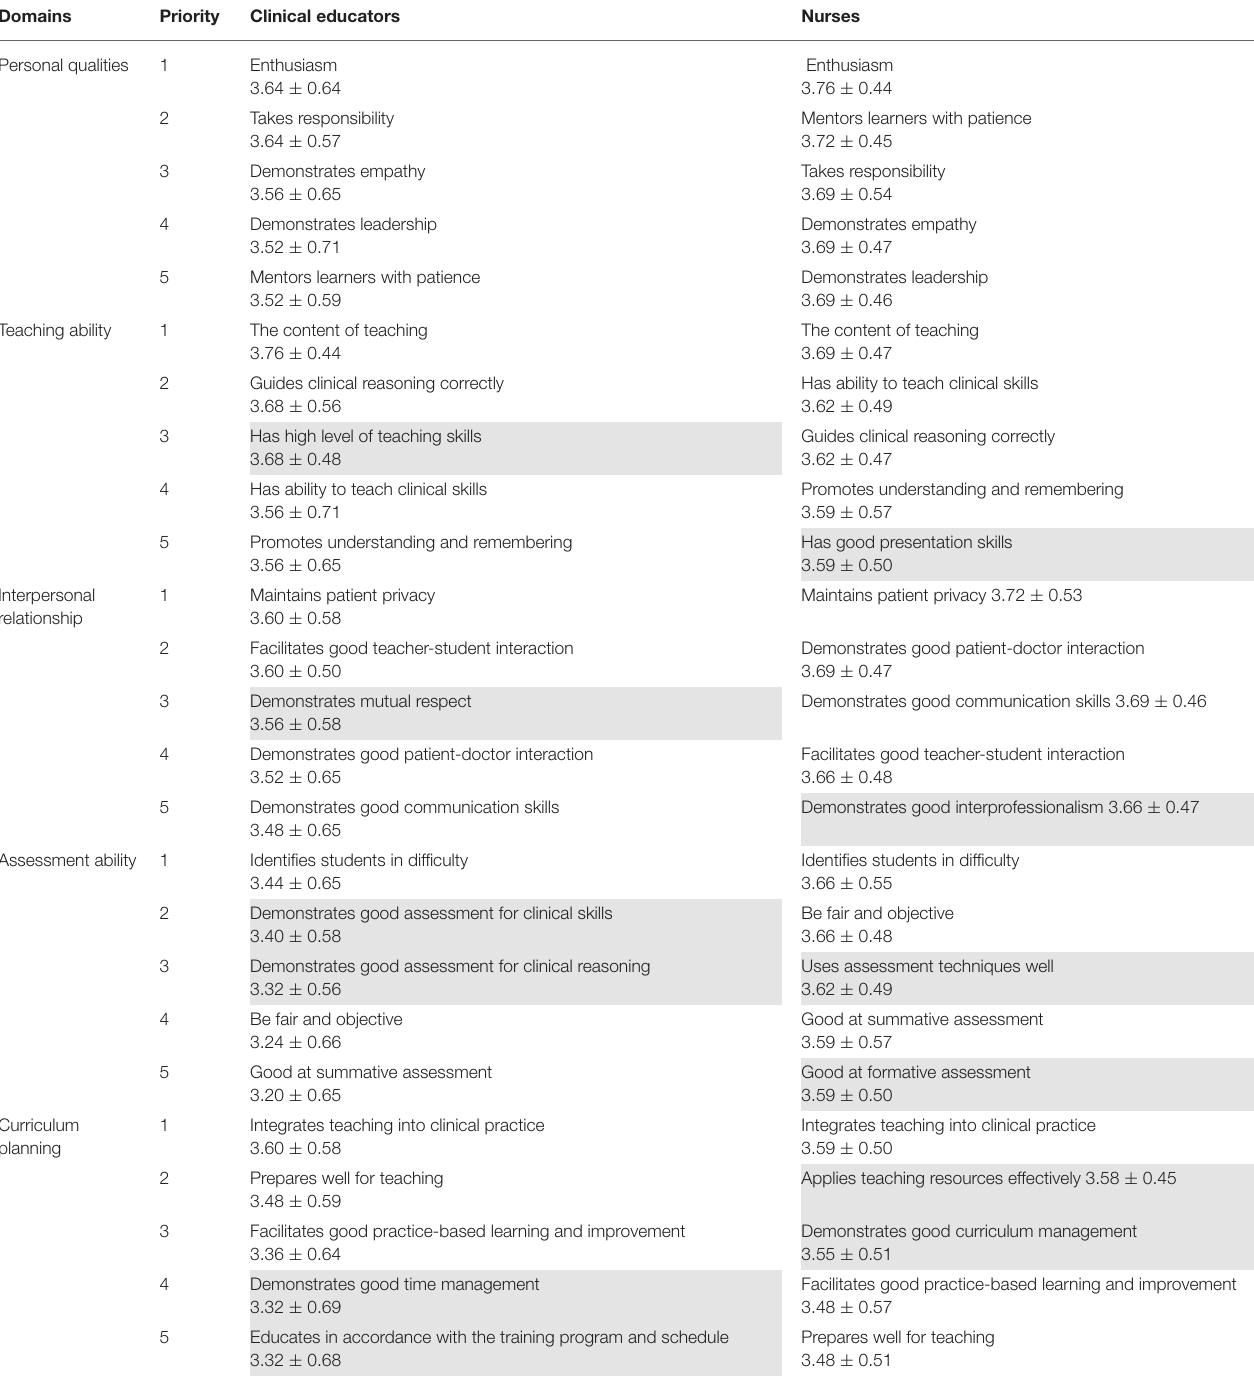
TABLE 3 | Comparison of the top 5 items prioritized by clinical educator and nurse groups across all domains.